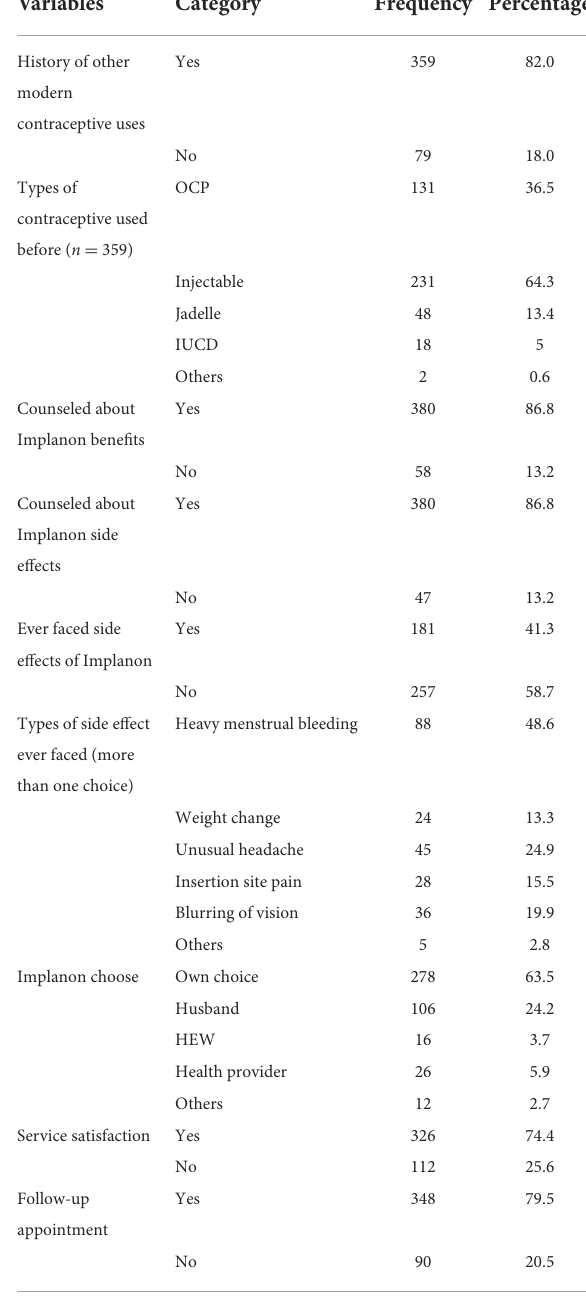
TABLE 3 Contraceptive method utilization and related characteristics among women visiting public health facilities to discontinue implanon in Kembata Tambaro Zone southern Ethiopia, 2020 ( n =